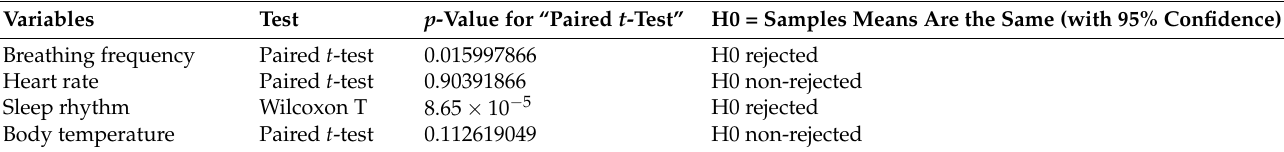
Table 12. Result of difference of means test for male